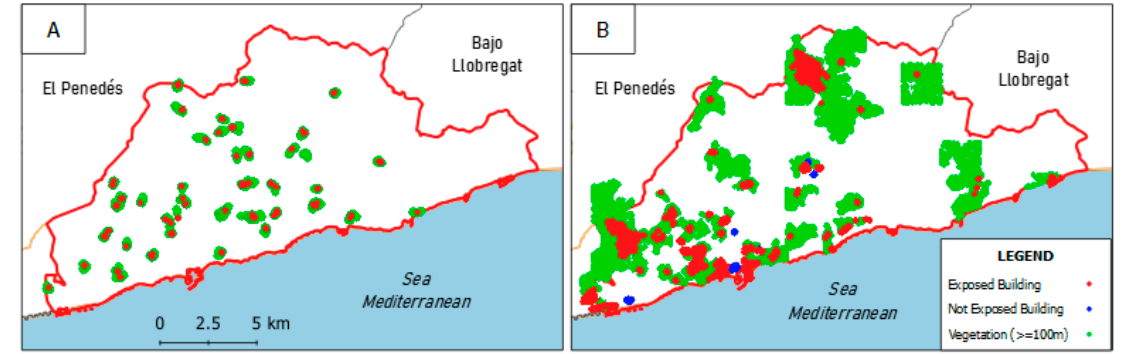
Figure 9. Clusters distribution in municipalities of Madrid for analysis of intermix (A) and interface (B)